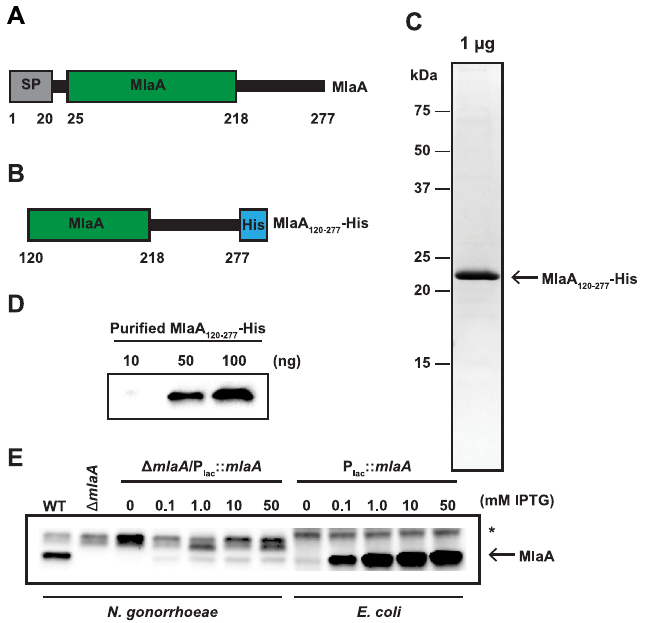
Fig 3. Purification of a truncated recombinant version of MlaA and polyclonal anti-MlaA serum validation. (A) Representative schematic of full length MlaA with annotated MlaA domain. A signal peptide (SP) is noted by a grey rectangle. (B) Schematic of truncated MlaA used for purification with first 119 amino acids removed and a 6 × Histidine tag (His; as a blue rectangle) added to the N-terminus. Schematics are not to scale. (C) Truncated MlaA construct was overexpressed in E . coli and purified by nickel affinity chromatography in the presence of 1% Triton-X 100 detergent. Detergent was subsequently removed by incubation with Bio-Rad Bio-Beads SM-2 resin. To assess purity, 1 μ g of protein was subjected to 1D SDS-PAGE and visualized by staining with Colloidal Coomassie Blue G- 250. Open arrow indicates migration band of MlaA 120-277 . Migration of a molecular weight marker (in kDa) is indicated to the left of the gel. (D) Immunoblot evaluation of anti-MlaA antiserum. Indicated amounts of purified MlaA 120-277 were separated by SDS-PAGE, transferred to a nitrocellulose membrane, and probed with anti-MlaA antiserum. (E) Equivalent OD 600 units of WT, isogenic Δ mlaA , and either Δ mlaA /P lac :: mlaA or E . coli harboring the pGCC4- ngo2121 complementation plasmid cultured with indicated concentrations of IPTG, were separated by SDS-PAGE, transferred to a nitrocellulose membrane, and probed with anti-MlaA antiserum. Open arrow indicates MlaA. Non-specific cross-reactive band is marked with an asterisk ( � ). OD 600 , optical density at 600 nm; IPTG, isopropyl β -D-thiogalactopyranoside; SDS-PAGE, sodium dodecyl sulfate-polyacrylamide gel electrophoresis.